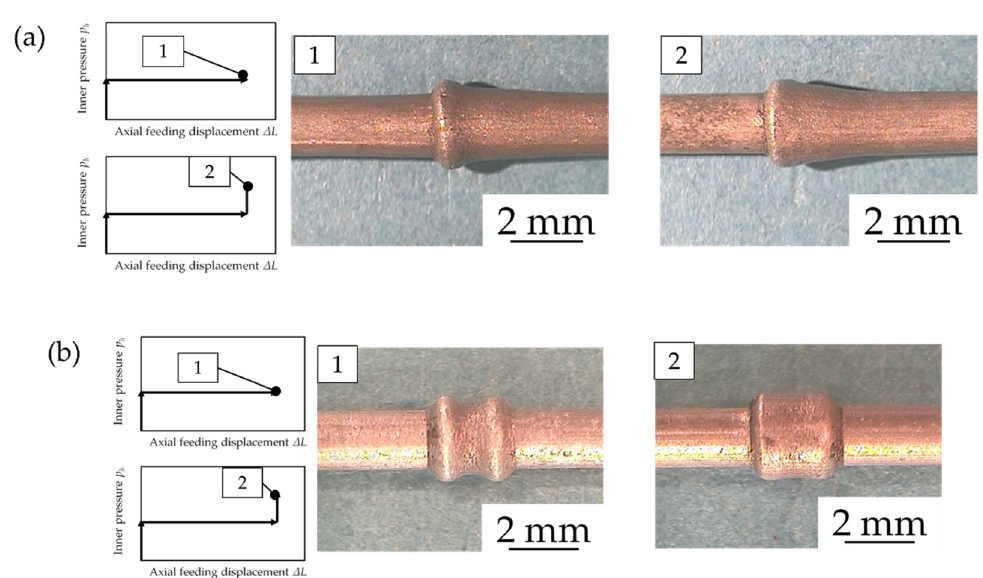
Figure 21. Deformation behavior of the small ZM21 tubes, which were deformed based on the modified loading path at 250 °C: ( a ) taper-shaped tube; ( b ) cylinder-shaped tube.